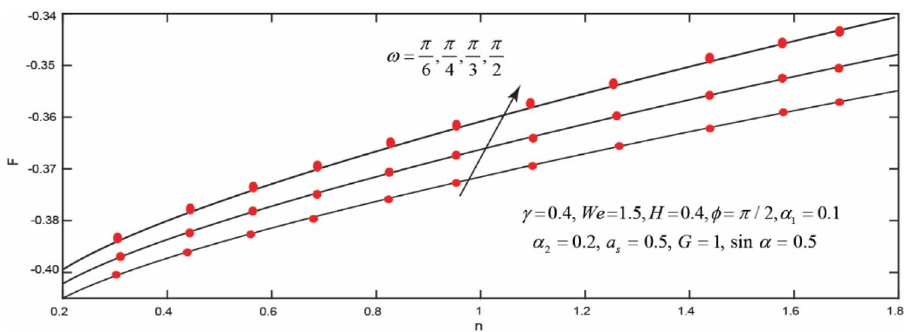
Figure 5. Impact of inclined angle ω on organisms swimming speed.